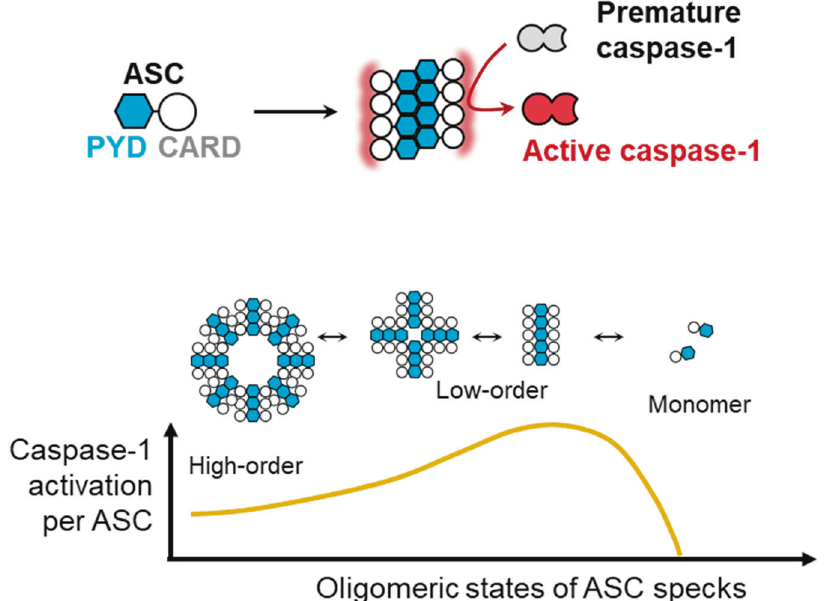
Fig. 6 Proposed model for enhanced activation of caspase-1 in the extracellular space through ASC specks with low oligomeric states. ASC specks with a low degree of oligomerization have more ASC CARD available for the homotypic interactions between ASC CARD and caspase- 1 CARD , increasing the activation of caspase-1 in in fl ammatory